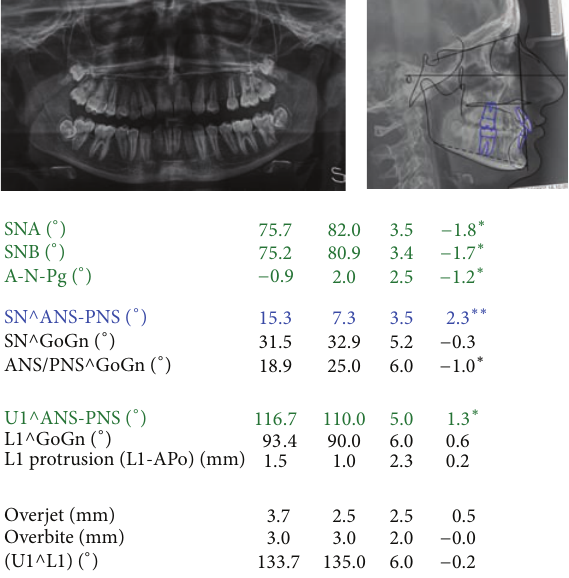
Figure 3: Cephalometric values and panoramic radiograph at the start of treatment. From left to right: value measured, average value from the population norm, standard deviation of the average value from the population norm, and difference from the extreme value of the population norm. Blue: values above the norm; green: values below the norm; black: values within the